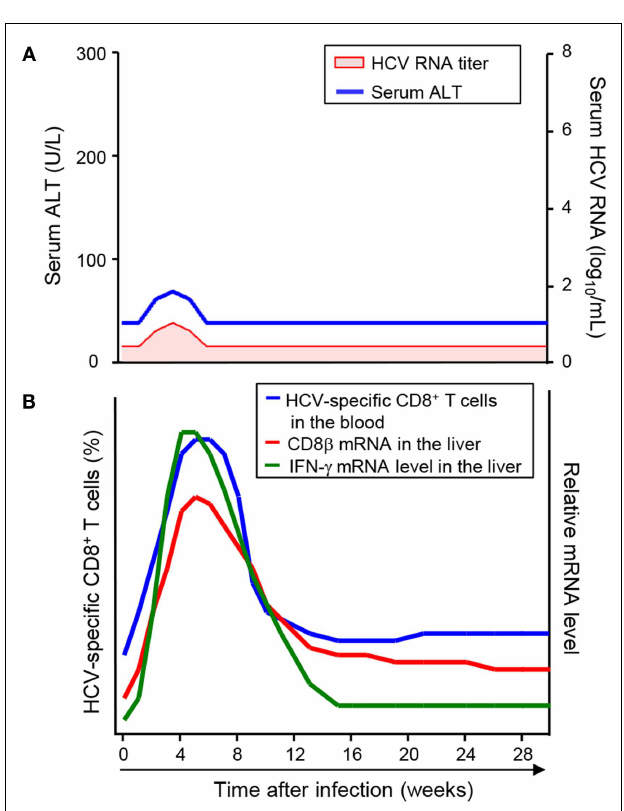
FIGURE 3 |Virologic course and kinetics of CD8 + T-cell responses after HCV challenge in successfully vaccinated hosts . (A) Virologic course after HCV challenge in successfully vaccinated hosts (23). HCV RNA was transiently detected and disappeared, and serum ATL was also transiently elevated. (B) Kinetics of CD8 + T-cell responses after HCV challenge in successfully vaccinated hosts (19, 24). Early CD8 + T-cell responses are shown by the frequency of HCV-specific CD8 + T-cells in the blood and mRNA levels of CD8 β and IFN- γ in the